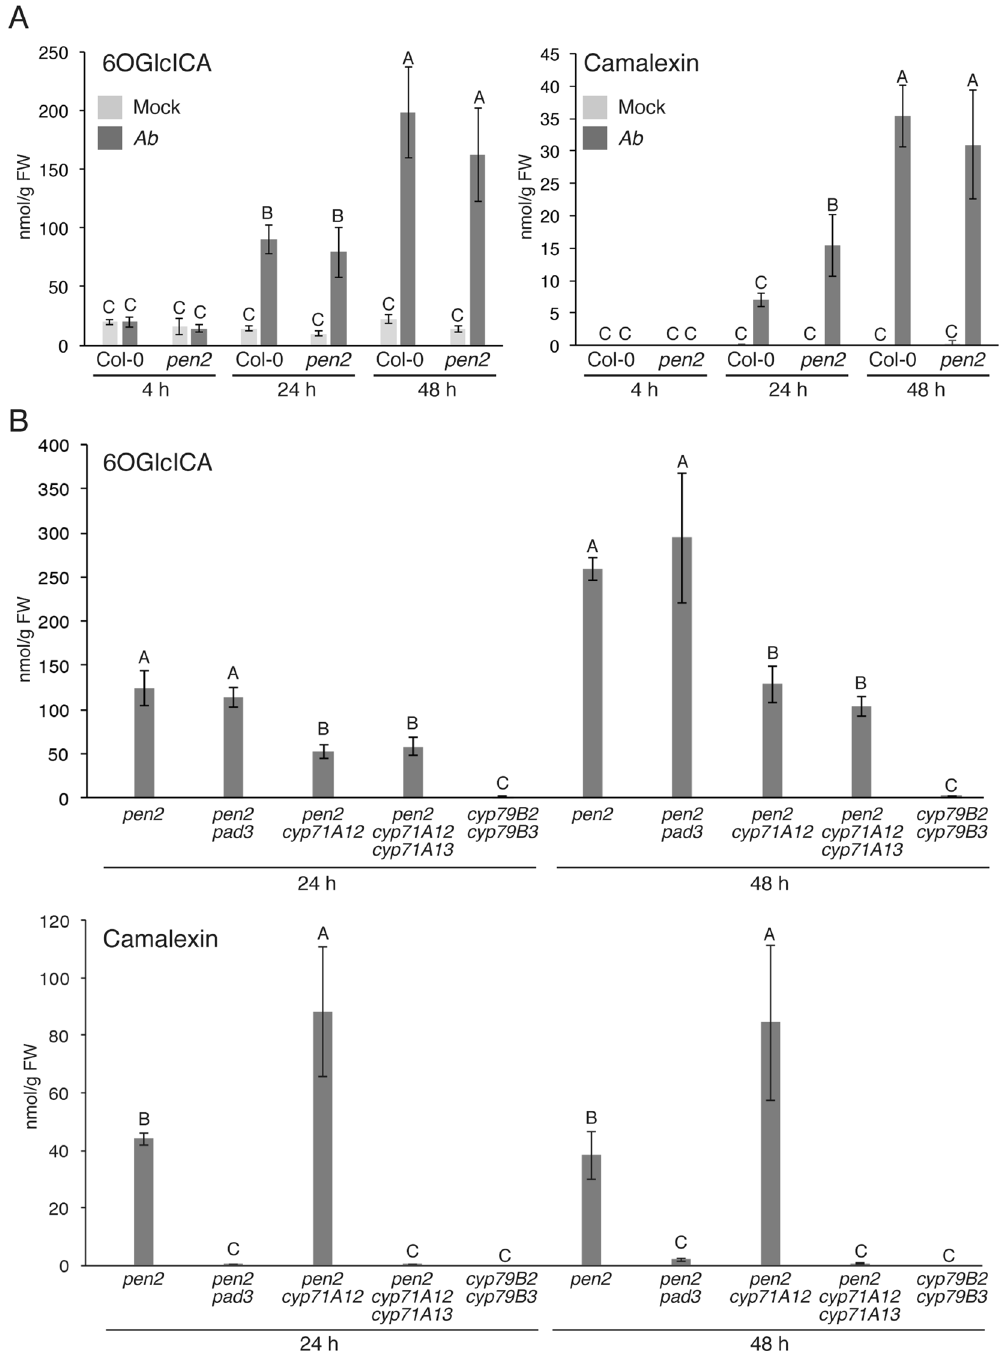
Figure 3. Invasion by Ab induced CYP71A12-dependent biosynthesis of 6-hydroxy-ICA and PAD3-dependent biosynthesis of camalexin. ( A ) The accumulation of 6-hydroxy-ICA (6OGlcICA) and camalexin in Arabidopsis plants inoculated with Ab . Conidial suspensions (5 × 10 5 conidia/mL) of Ab were spray-inoculated onto Col-0 (WT) and pen2 plants. As a control, water was sprayed as a mock treatment. The means of metabolites (nmol/g fresh weight, FW) and SDs from four biological independent samples are shown in the graph. The statistical significance of differences between means was determined by Tukey’s HSD test. Means not sharing the same letter are significantly different ( P < 0.05). ( B ) CYP71A12 is required for the Ab -triggered accumulation of 6OGlcICA, whereas PAD3 and CYP71A13 are required for the accumulation of camalexin. Conidial suspensions (5 × 10 5 conidia/mL) of Ab were spray-inoculated onto tested mutant lines. The statistical significance of differences between means in each time point was determined by Tukey’s HSD test. Means not sharing the same letter are significantly different ( P <